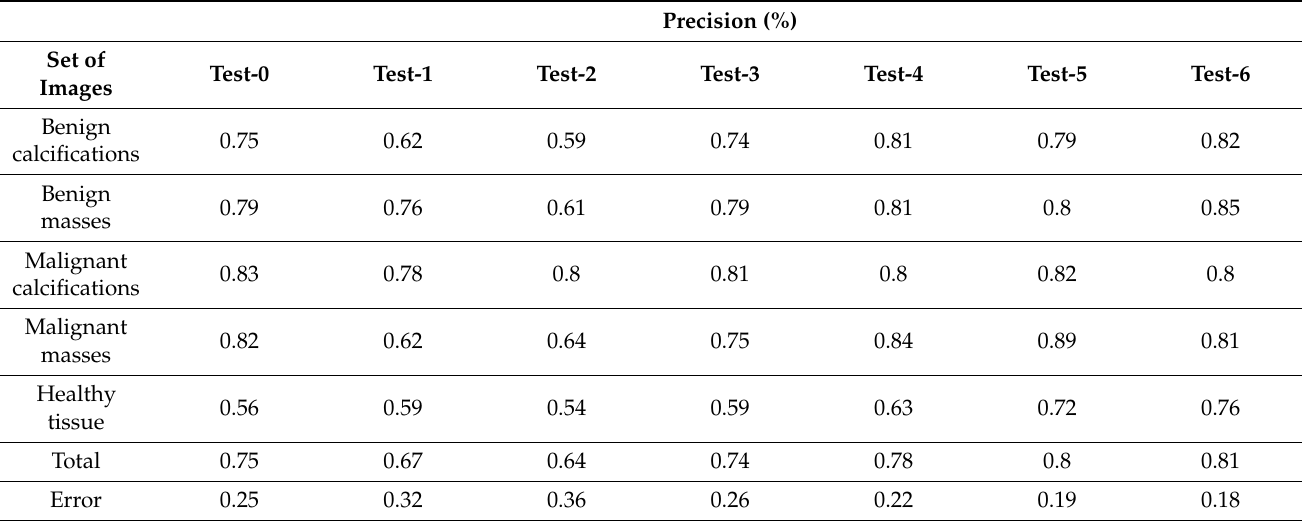
Table 5. Results obtained during the tests. The total precision is displayed along with the individual precisions for each set of images